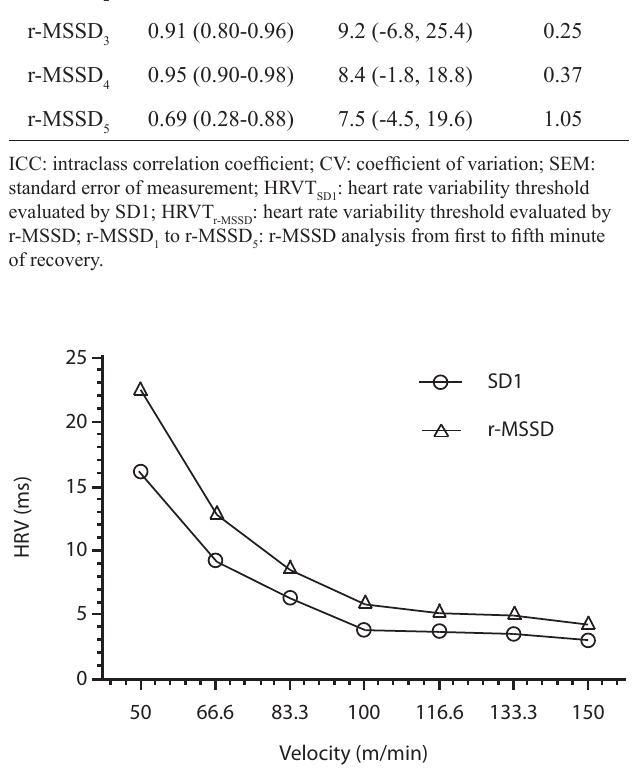
Figure 1 . Heart rate variability dynamics during a submaximal ex - ercise